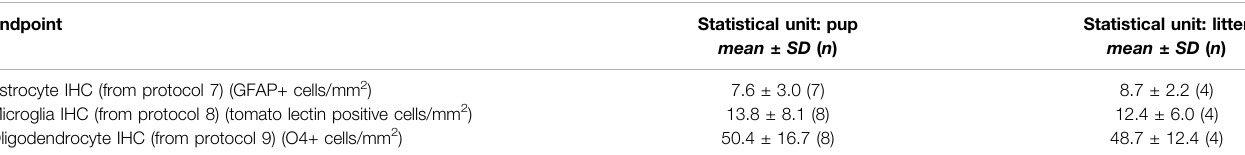
TABLE 7 | Results of PROTOCOLS 7, 8, and 9